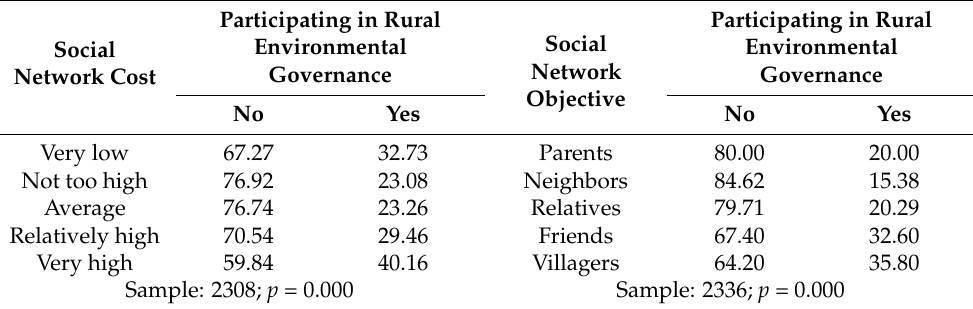
Table 4. Cross analysis of social network and resident participation in rural environmental governance (Units: